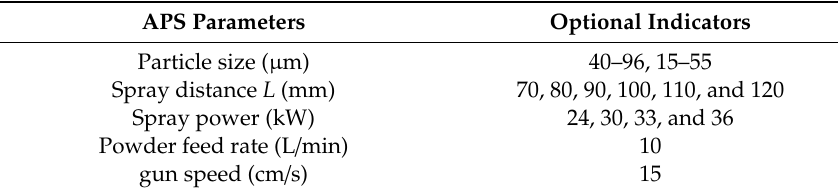
Table 1. The atmospheric-plasma-sprayed (APS) process parameters for deposition of the 8 wt.% yttria partially stabilized zirconia (YSZ) ceramic top coatings.